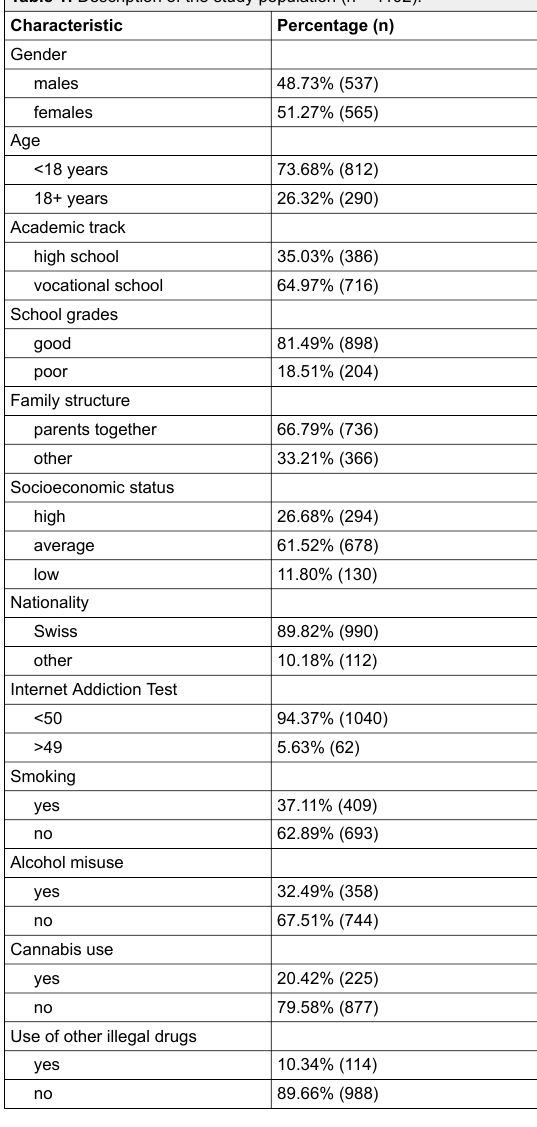
Table 1: Description of the study population (n =